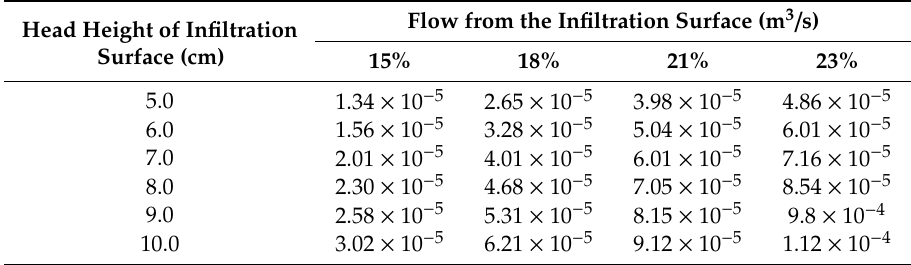
Table 4. Results of infiltration flow test measurements at infiltration surfaces corresponding to di ff erent infiltration head heights.